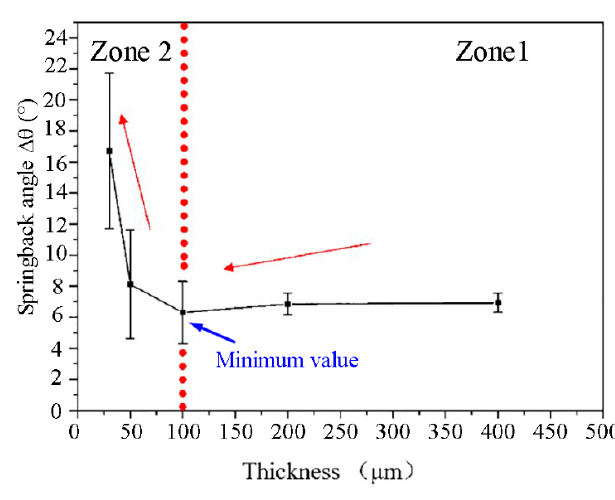
Figure 4. The variation of springback angle with thickness.